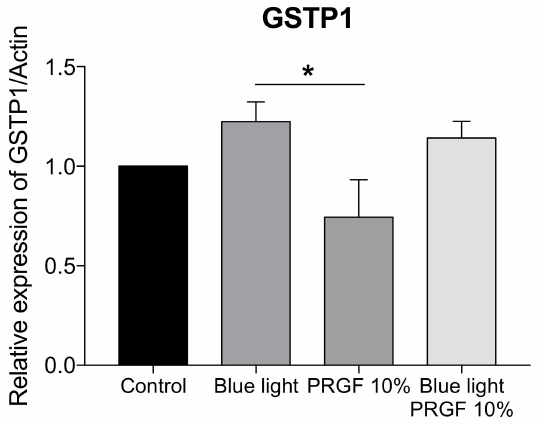
Figure 5. Gene expression of GSTP1 related to actin in ARPE19 cell cultures ( n = 4). Blue light increased the expression of GSTP1, and PRGF reduced it significantly. Statistical analysis: One-way ANOVA, Tukey multiple comparison test, and * p <